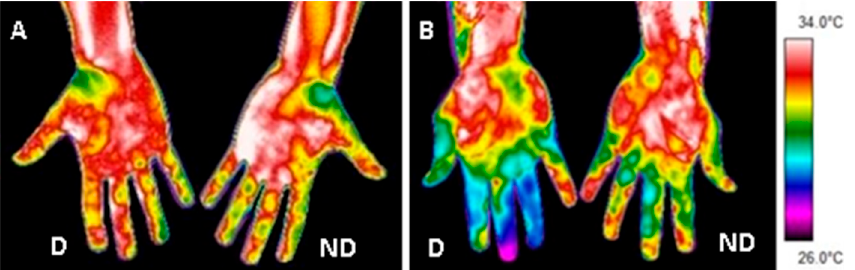
Figure 3. Example of the thermal images at baseline condition in a member of the control group ( A ) and a member of the athlete group ( B ). D = Dominant Hand; ND = Non-Dominant Hand. The athletes group reported higher Tsk in all the ROIs of the dominant and non- dominant hands after the match than before it ( p < 0.05; g = 0.5–1.0), except Index